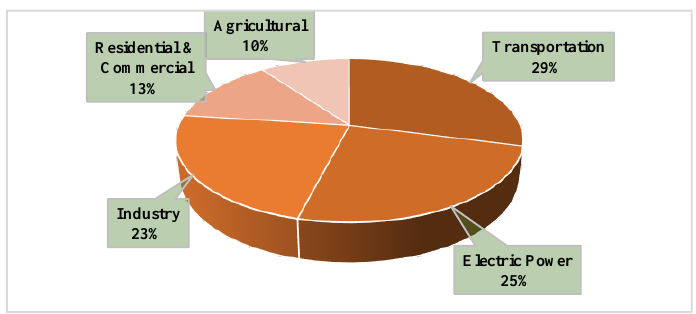
Figure 1. Greenhouse gas emissions by sector as of 2022.